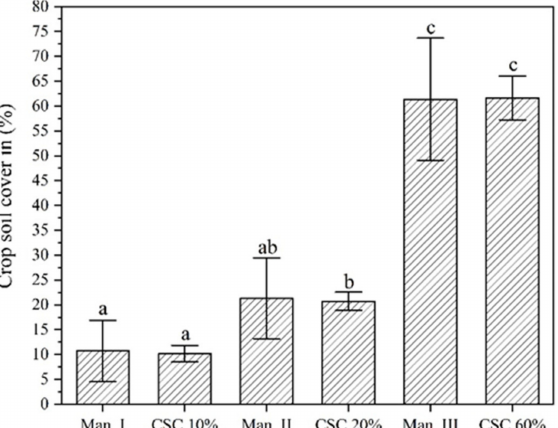
Figure 2. Mean crop soil cover (CSC) and standard deviation measured in Eningen and Hirrlingen in 2020 after harrowing in three conventional and three automatic settings, p = 0.0034. Means with the same letter were not significantly different according to the HSD-test at α ≤ 0.05. Man_I = low conventional adjustment of tine angle (10 ◦ ); Man_II = medium conventional adjustment (tine angle 40 ◦ ); Man_III high conventional adjustment (tine angle 70 ◦ ); CSC 10% = threshold for automatic adjustment, soil burial 10%; CSC 20% = threshold for automatic adjustment, soil burial 20%; CSC 60% = threshold for automatic adjustment, soil burial